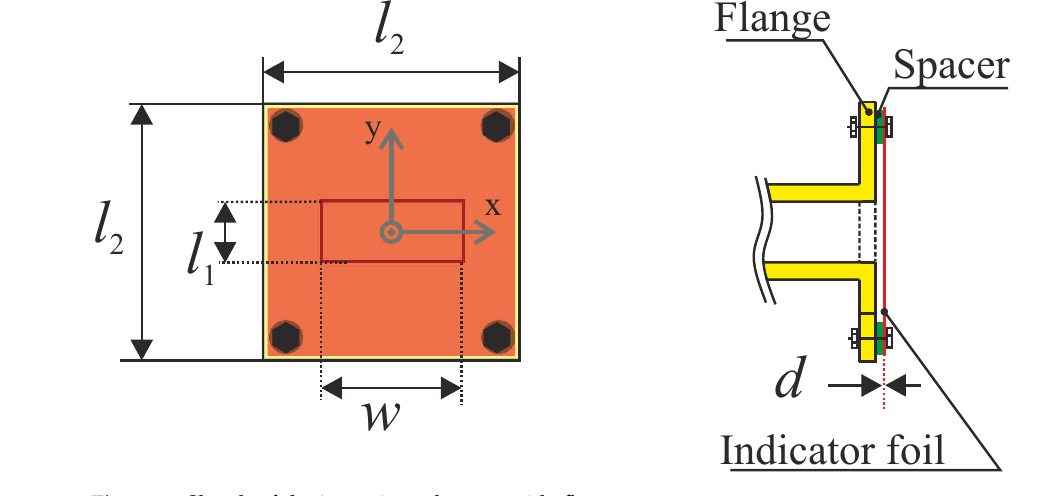
Figure 4. Sketch of the investigated waveguide